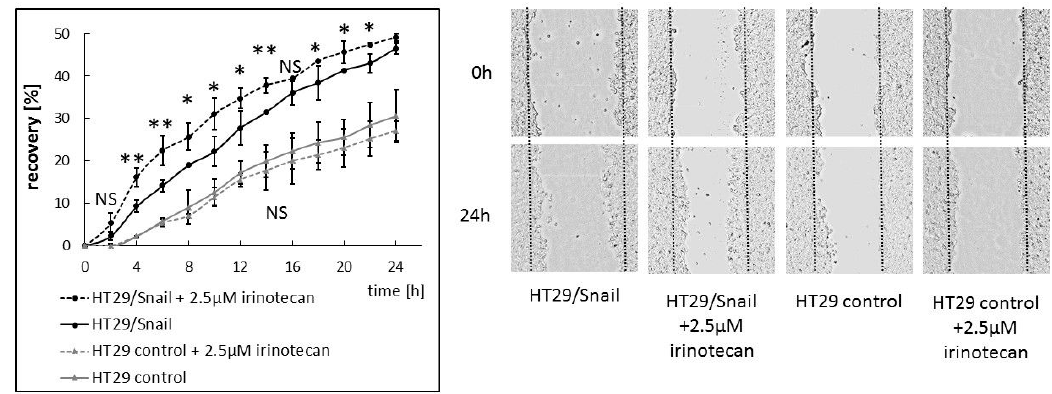
Figure 6. Irinotecan affects CRC migration. HT29 control and HT29/Snail cells were seeded on 24 well plate to confluence for 24 h. Next, wound was done across monolayer and fresh medium was added w/wo 2,5 µM irinotecan (final concentration). Wounded area was visualized after every 2 h by Spark multimode microplate reader (TECAN, Swizerland). Wounded area was calculated by ImageJ software [32]. Cell motility was estimated through the quantification of the % of recovery using the equation: R(%) = [1 − (wound area at Tt/wound area at T0)] × 100,where T0 is the wounded area at 0 h and Tt is the wounded area after 2 or 4 h. * p < 0.05; ** p < 0.005, NS—no statistically significant (all HT29 control vs HT29 control + 2,5 µM irinotecan were considered NS), n = 3.